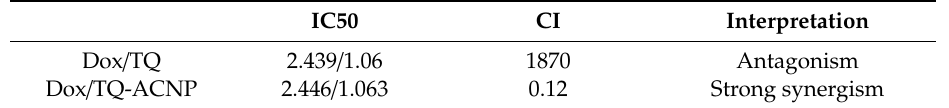
Table 2. CI and interpretation for the free Dox and TQ combination treatment and Dox / TQ-ACNP against the 3D mammosphere. IC50